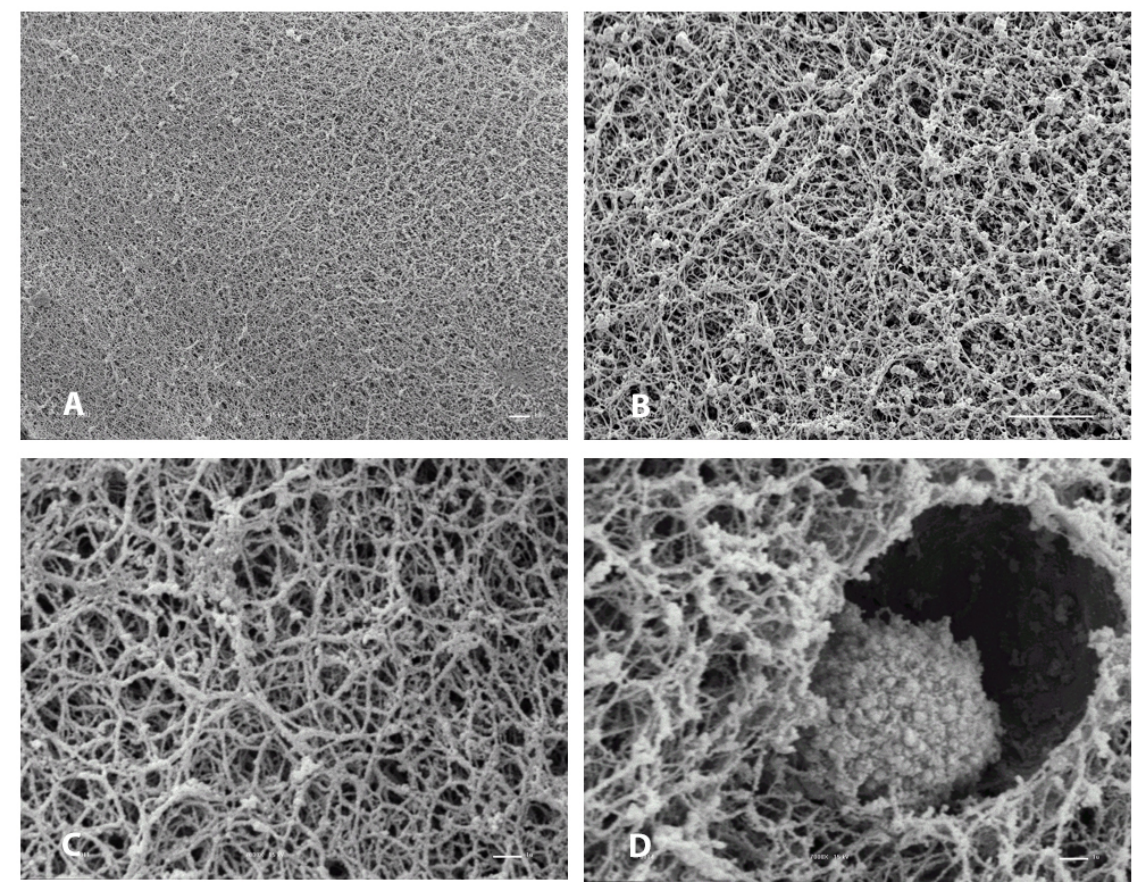
Figure 6. Electron microscopy of the heterologous fibrin sealant at different magnifications. (A) 500x; (B) 2000x; (C) 7000x and (D) 7000x with a captured mesenchymal stem